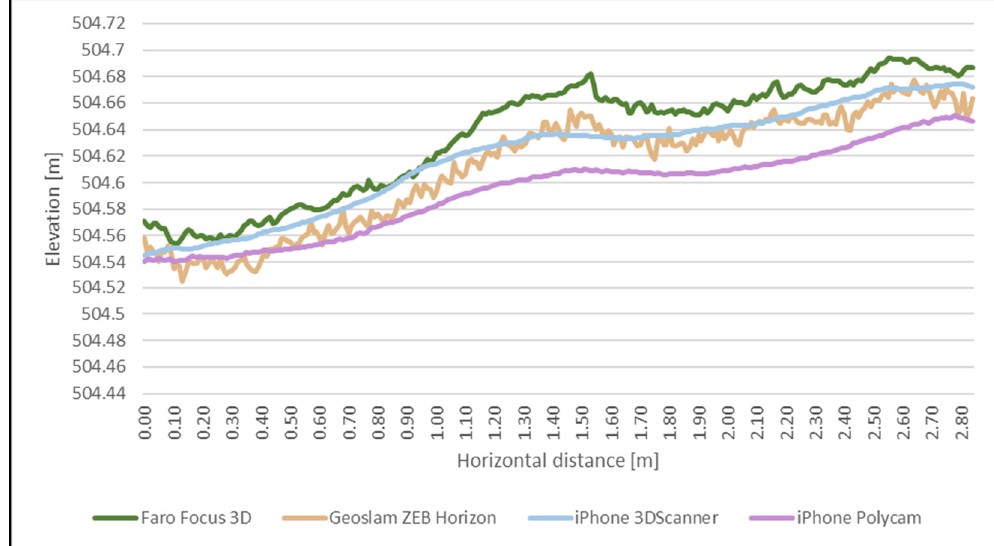
Figure 6. Cross profile example—road section No. 1.